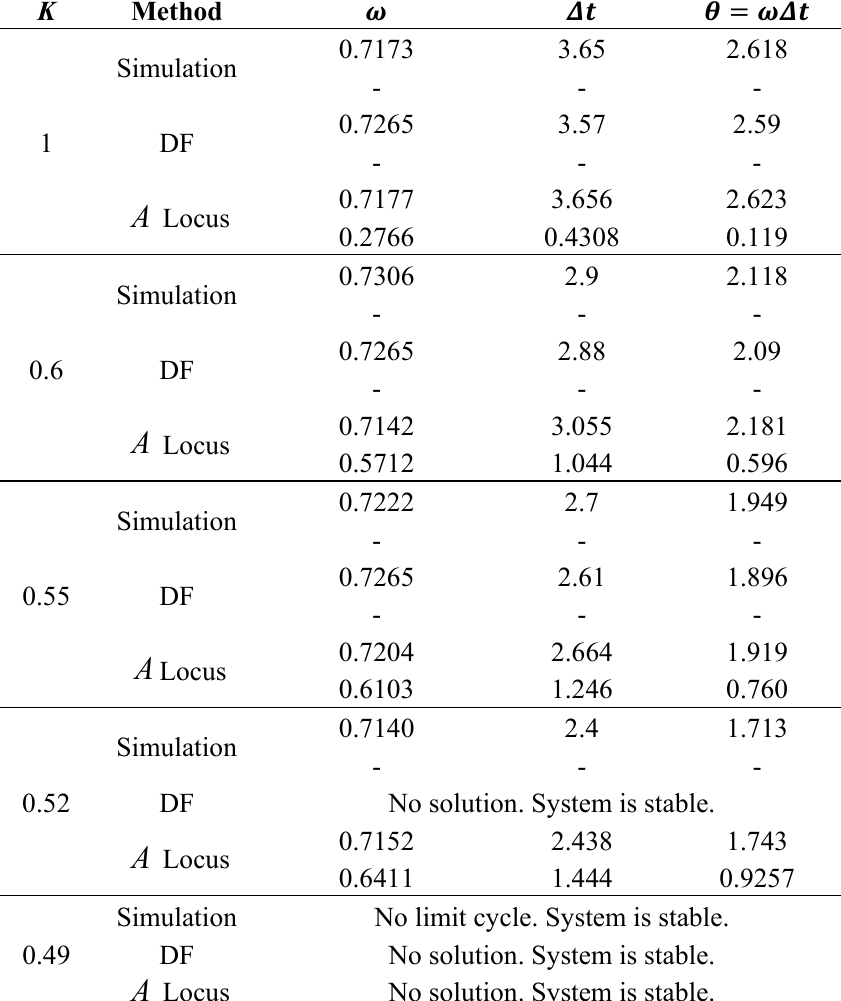
Table 6. Results from simulation, DF and A Locus methods.